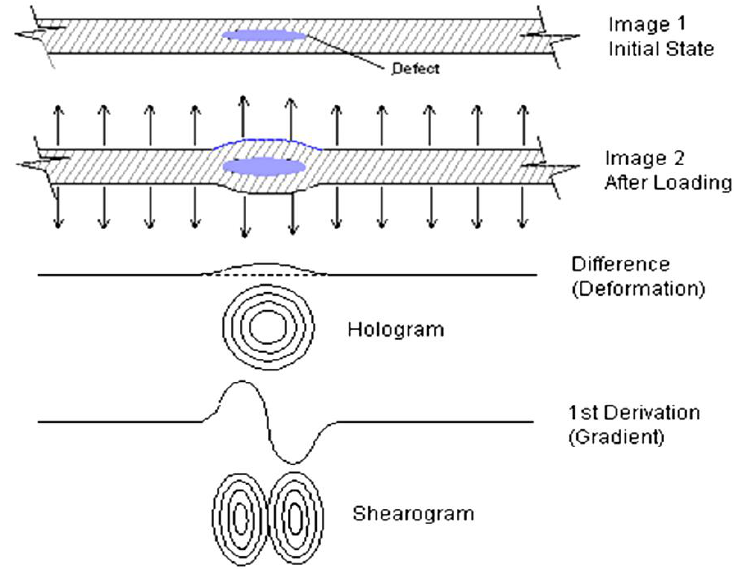
Figure 2. Comparison between the NDT results of holography and